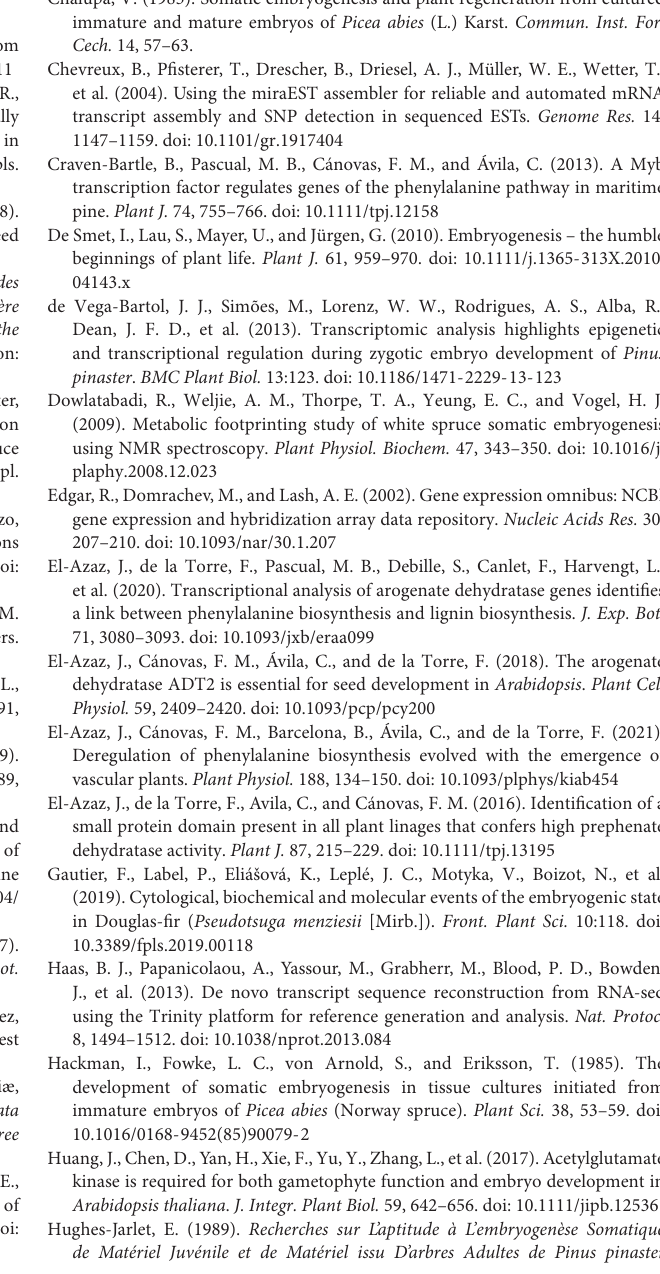
Supplementary Figure 1 | Validation of differentially expressed transcripts by qPCR. Supplementary Figure 2 | Pathway map of nitrogen and arginine metabolism. A general overview of the metabolic reactions involved is shown. Differentially regulated steps are colored in the map. Supplementary Figure 3 | Pathway map of phenylpropanoid metabolism. A general overview of the metabolic reactions involved is shown. Differentially regulated steps are colored in the map. Supplementary Table 1 | Samples of somatic and zygotic embryos used for RNA sequencing.